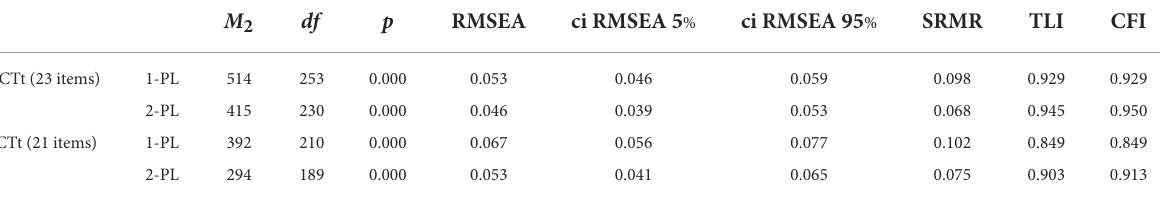
TABLE 6 IRT model parameter fit indices for 1-PL and 2-PL models with the BCTt and